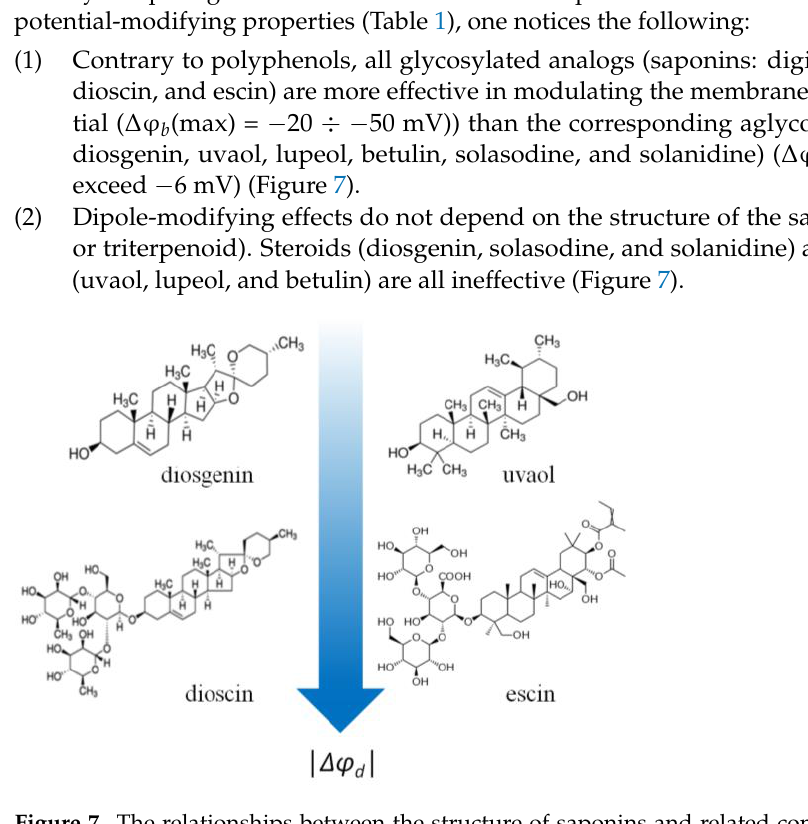
Figure 7. The relationships between the structure of saponins and related compounds and their modifying ability. Glycosylated analogs are more effective in modulating the membrane boundary potential than the corresponding aglycones independently of sapogenin core structure, steroid (left side) or triterpenoid (right side). The color intensity designation is shown in the caption of Figure 5. The different effect of glycosylation on the dipole-modifying ability of flavonoids